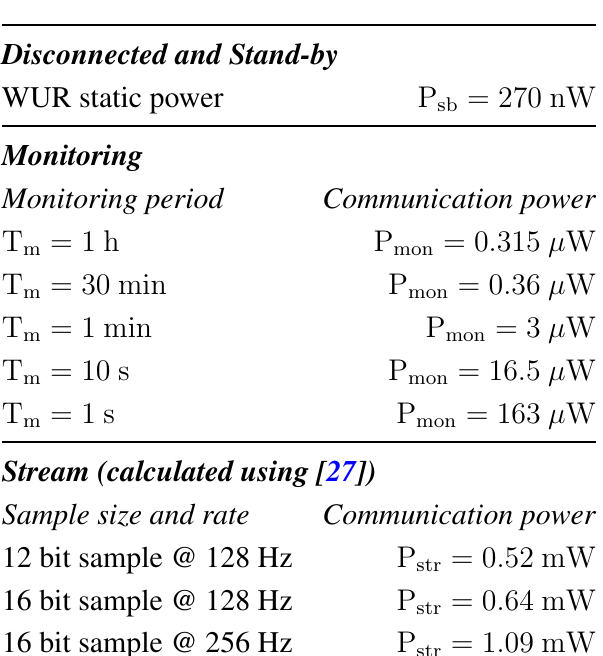
Table 2. Power consumption